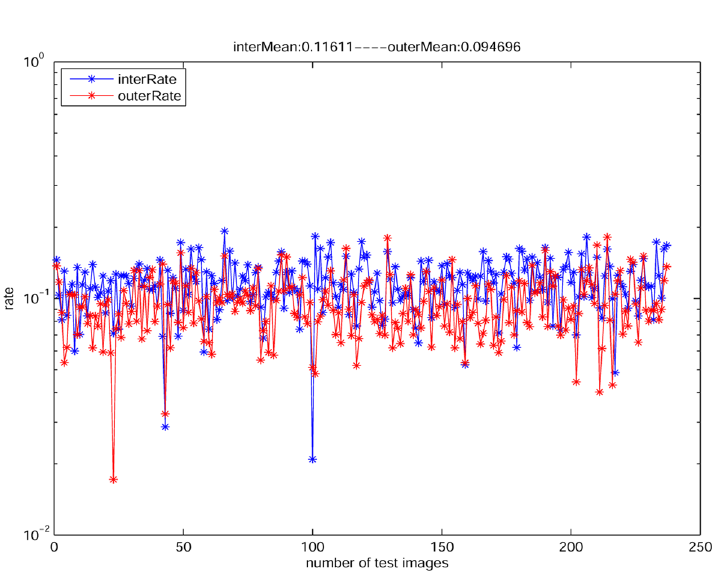
Fig 8. The rates of A E O The average rate of the 237 images is 0.116 for the blue points and 0.095 for the red points.